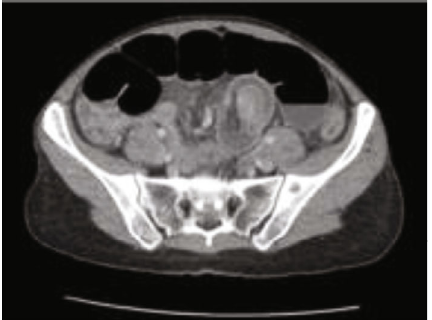
Figure 3: Computer tomography scan in the axial plane demonstrating multiple loops of dilated loops of the small bowel with and transition point within the left iliac fossa with the characteristic “ target ” sign suggesting high-grade small bowel obstruction likely secondary to